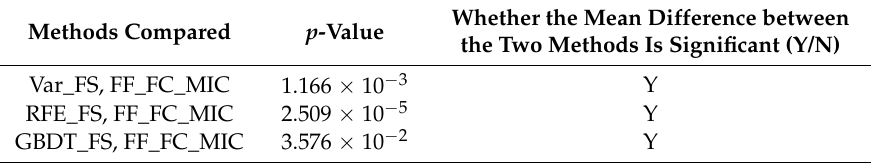
Table 8. Comparison between traditional feature selection methods and the proposed